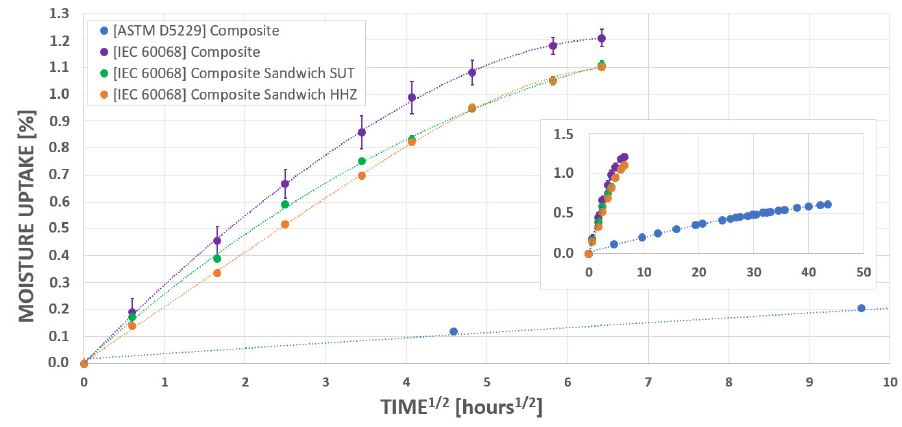
Figure 2. Moisture uptake for T300/EP composites and damped sandwiches with error bars.